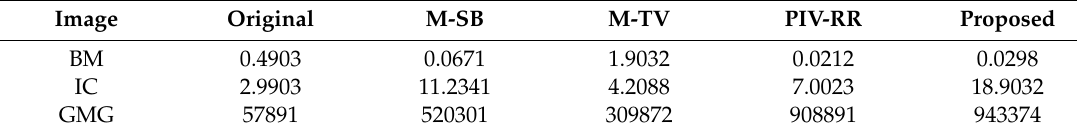
Table 7. Comparison of evaluation results.